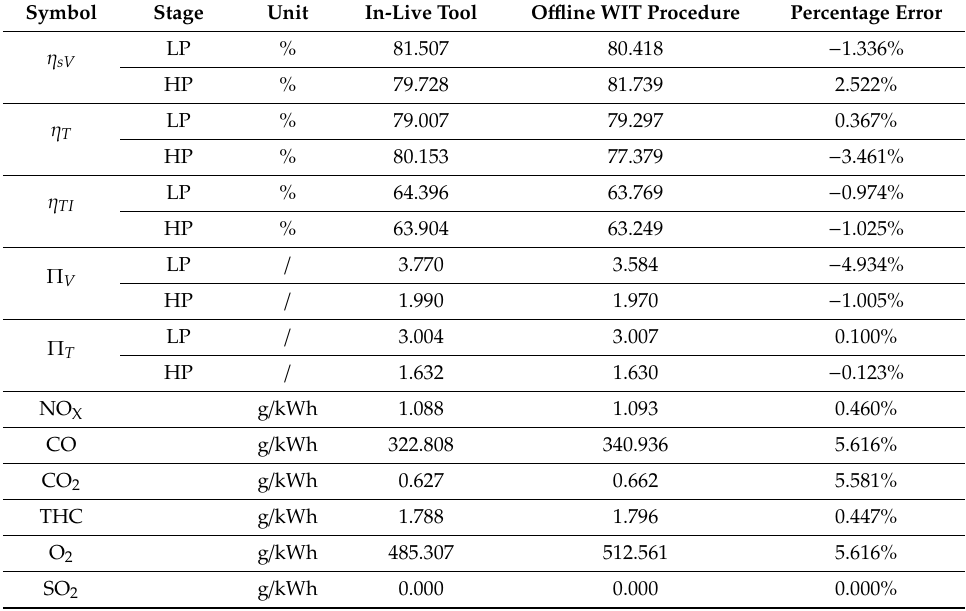
Table 8. Comparison between the output values–Carbon Balance method